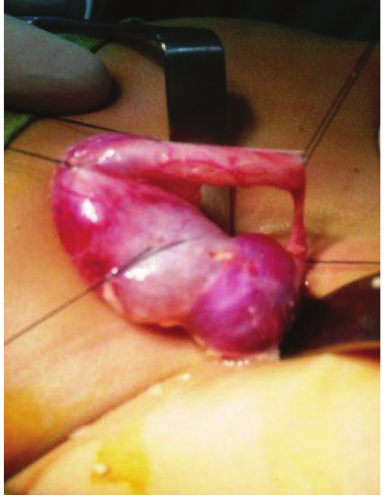
Figure 5: Photograph showing dilated ureter proximal to the stricture and distal normal caliber ureter.